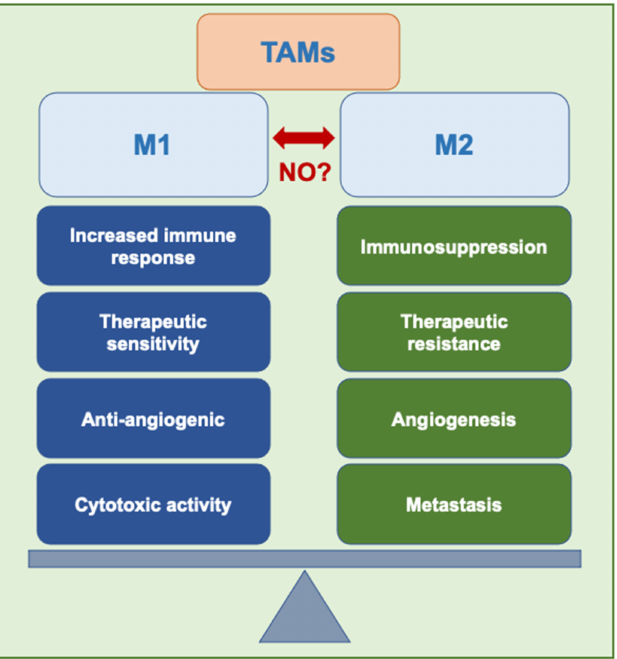
Figure 2. Repolarization of tumor-associated macrophages. M1-like and M2-like phenotypes shift expression depending on the microenvironment. Could iNOS-derived NO modulate